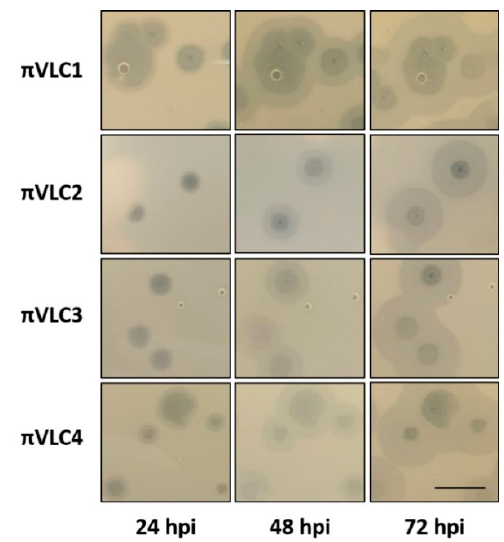
Figure 7. Development of plaque halos around Klebsiella pneumoniae phages π VLC1-4 plaques. Notice that halos kept expanding after the central lysis area ceased to grow. Scale bar: 1 cm.